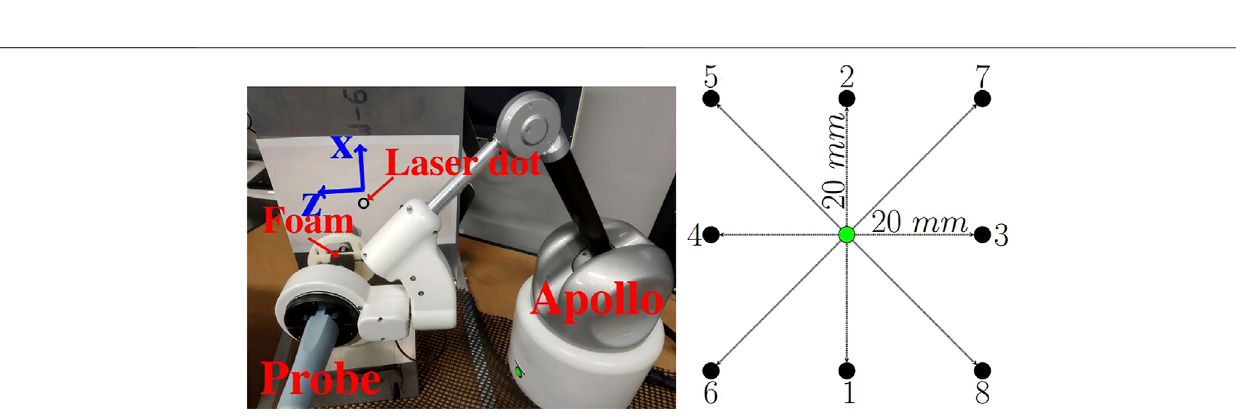
FIGURE 10 | Set-up and targets.